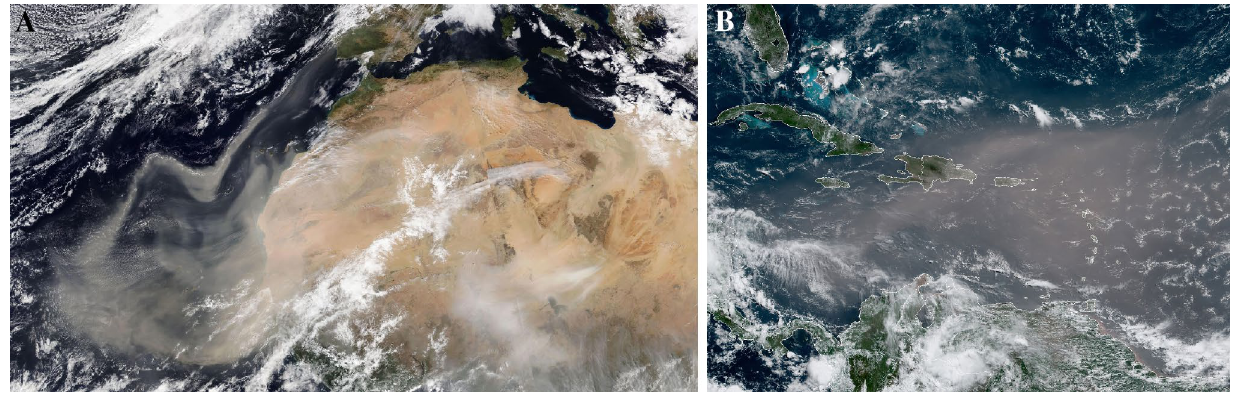
Fig. 1 True-color image of dust ( a ) and image enhancement ( b ) 2012 June